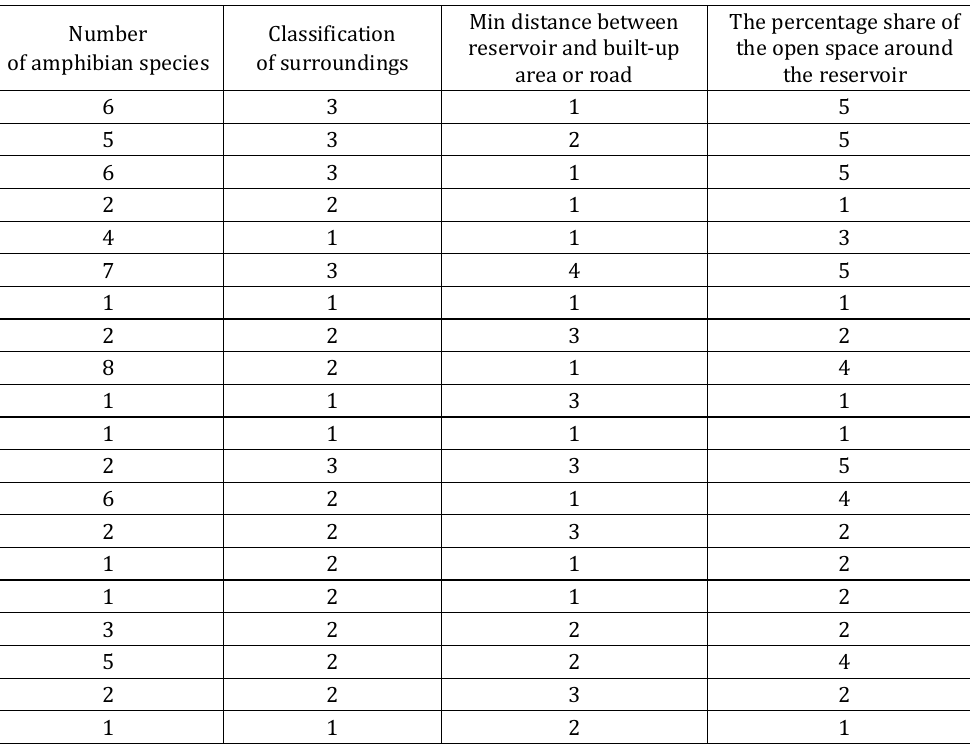
Fig. 2. The location of analyzed water reservoirs Table 3. The data